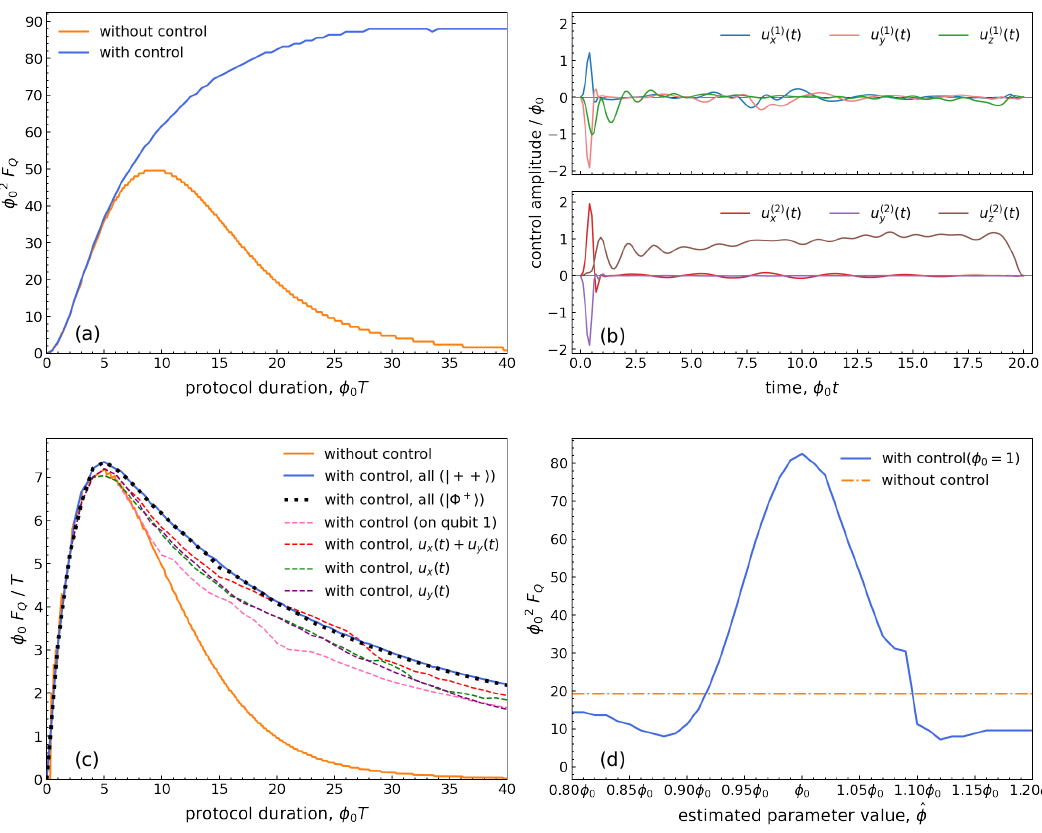
Figure 8: Local frequency estimation for a two-qubit system with XX coupling, − 2 φ = 1.0, g = 0.1, dephasing rate γ = 0.1 (a) The QFI (in units of φ ) achieved 0 0 − 1 without control and with control optimised for target time T (in units of φ ). (b) 0 Optimal controls obtained using Krotov’s method for the dynamics with T = 20. (c) Normalised QFI (by T ) without control (orange line), with control on both qubits (cid:12) + (cid:11) (black using a product state | ++ 〉 (blue line) or a maximally entangled state (cid:12) Φ dotted line) as probe, applying controls only on qubit 1 (pink dashed line), on both ( t ) (green dashed line), only u ( t ) (purple dashed line) qubits restricted to only u x y ( t ) + u ( t ) (red dashed line). (d) The QFI achieved at T = 20 by or having both u x y applying controls optimised with different estimated parameter values ˆ φ on states evolved under the true parameter value φ 0